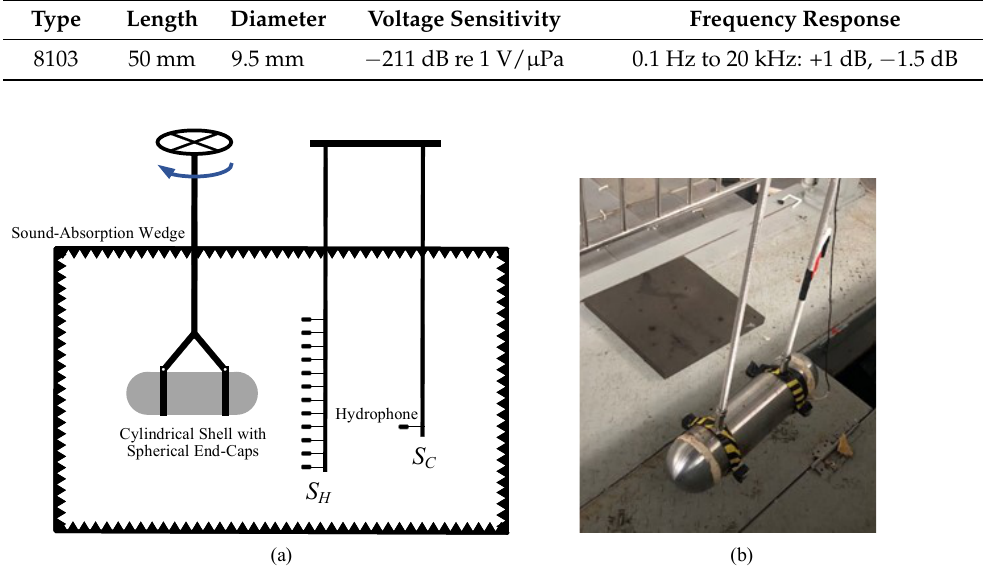
Figure 15. ( a ) The schematic diagram of experimental setup. S H is the measuring surface and S C is the verification point. ( b ) The photo of cylindrical shell used in the